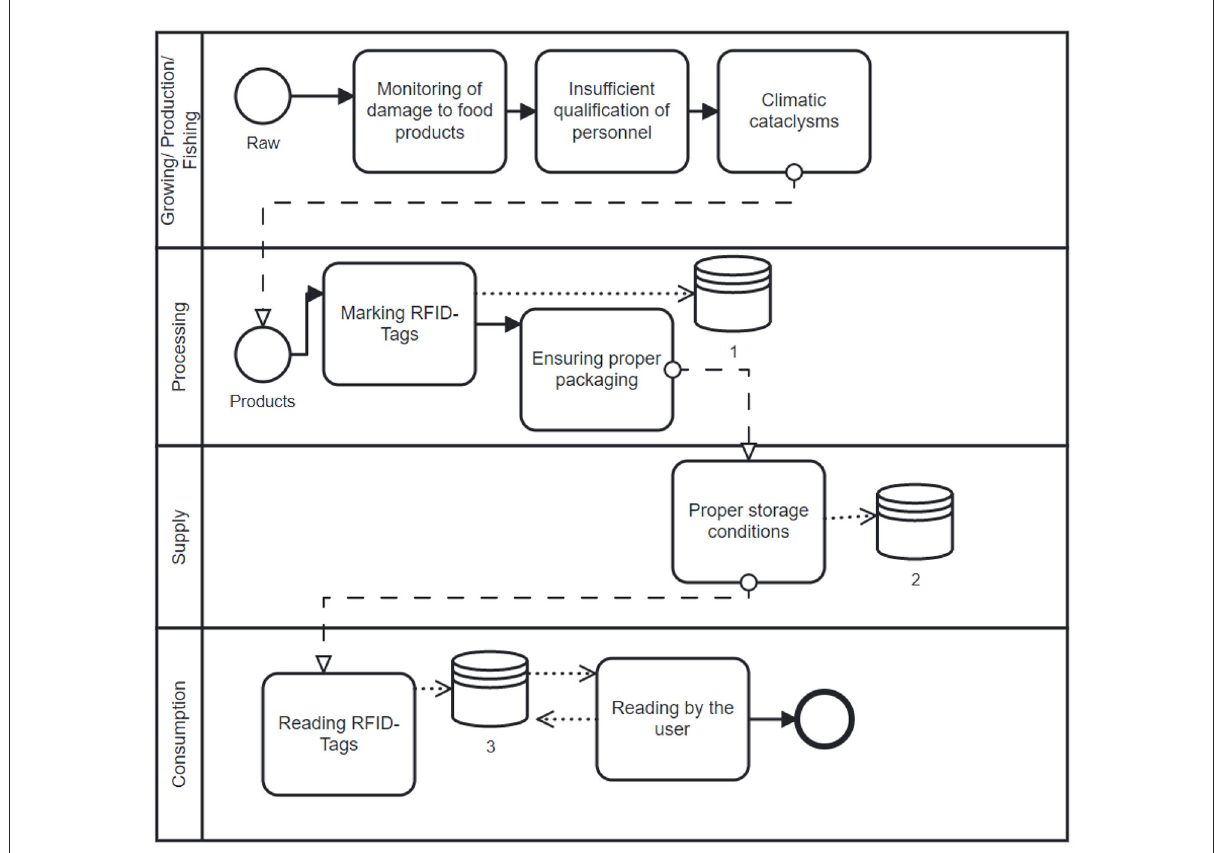
FIGURE1 The process of monitoring product expiration limits. Source: Authors’ depiction.